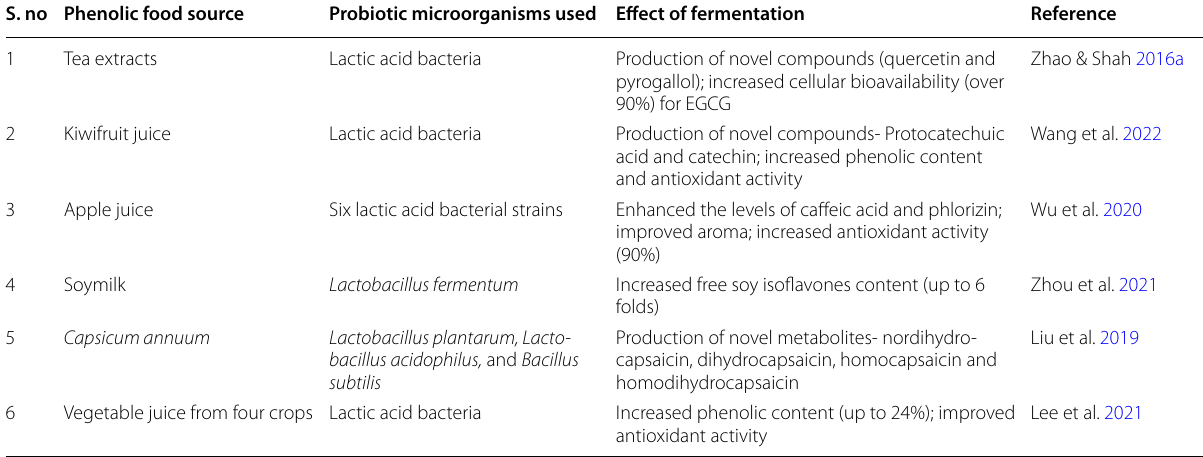
Table 1 Selected examples of probiotic fermentation-induced changes in phenolic rich foods S. no Phenolic food